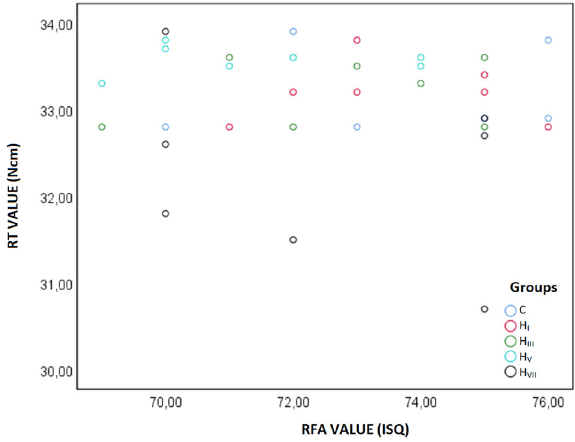
Fig. 6 Scatter plot of ISQ and Ncm